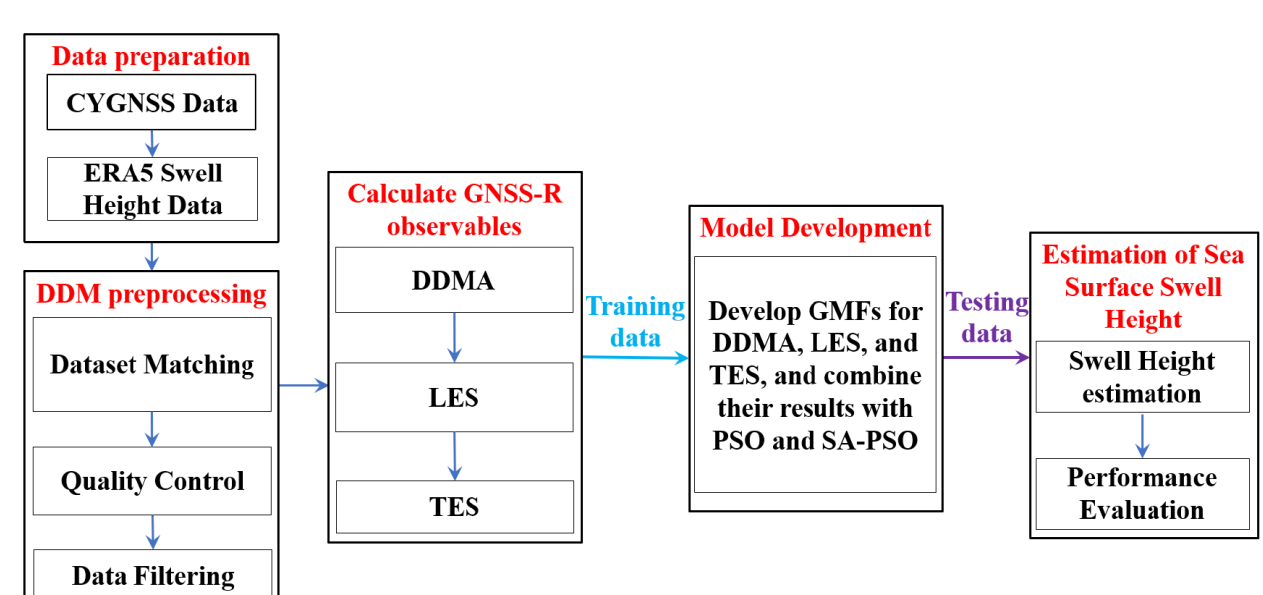
Figure 4. Flowchart of the GNSS-R based swell height estimation method. The first stage is data preparation, the second stage is DDM processing, the third stage is extraction of three GNSS-R observables, the fourth stage is the modeling process, the fifth stage is model performance verification and evaluation. Details of the stages are provided in the remainder of this